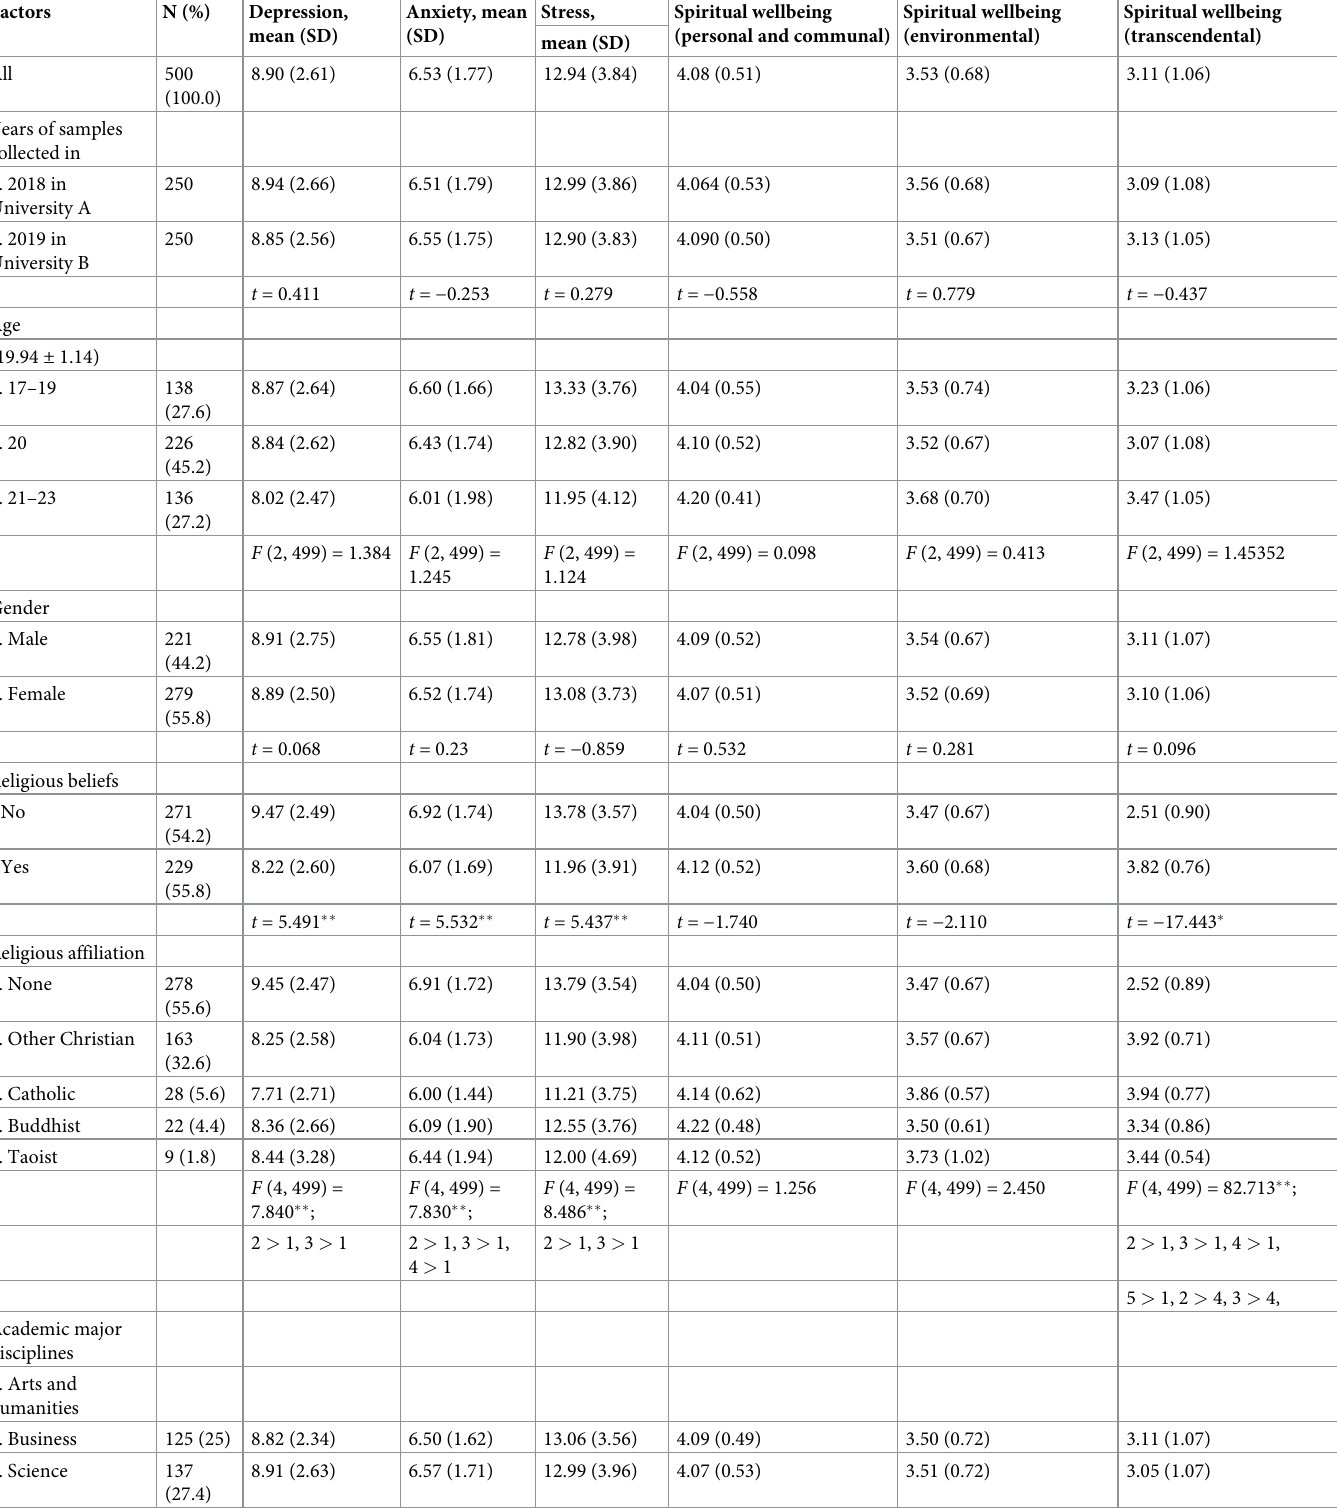
Table 2. Descriptive statistics: Participants’ demographics and their relationship with depression, anxiety and stress and spiritual wellbeing (N =